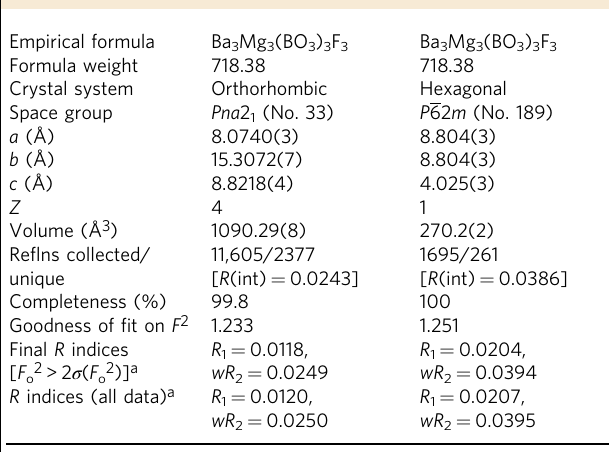
Fig. 2, which veri fi es the validity of structure-oriented design strategy. As shown in Fig. 2a, b, e, BMBF series possess a similar Table 1 Crystallographic data for Pna 2 1 -and P 6 2 m